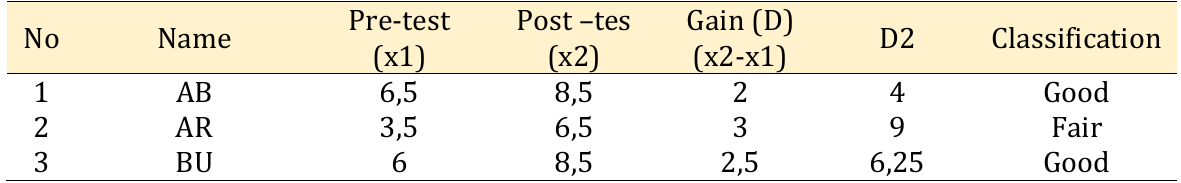
Table 2. Students’ score of pretest ( x1), posttest (x2) Gain/ difference between the matched pair (D), and the square of the gain